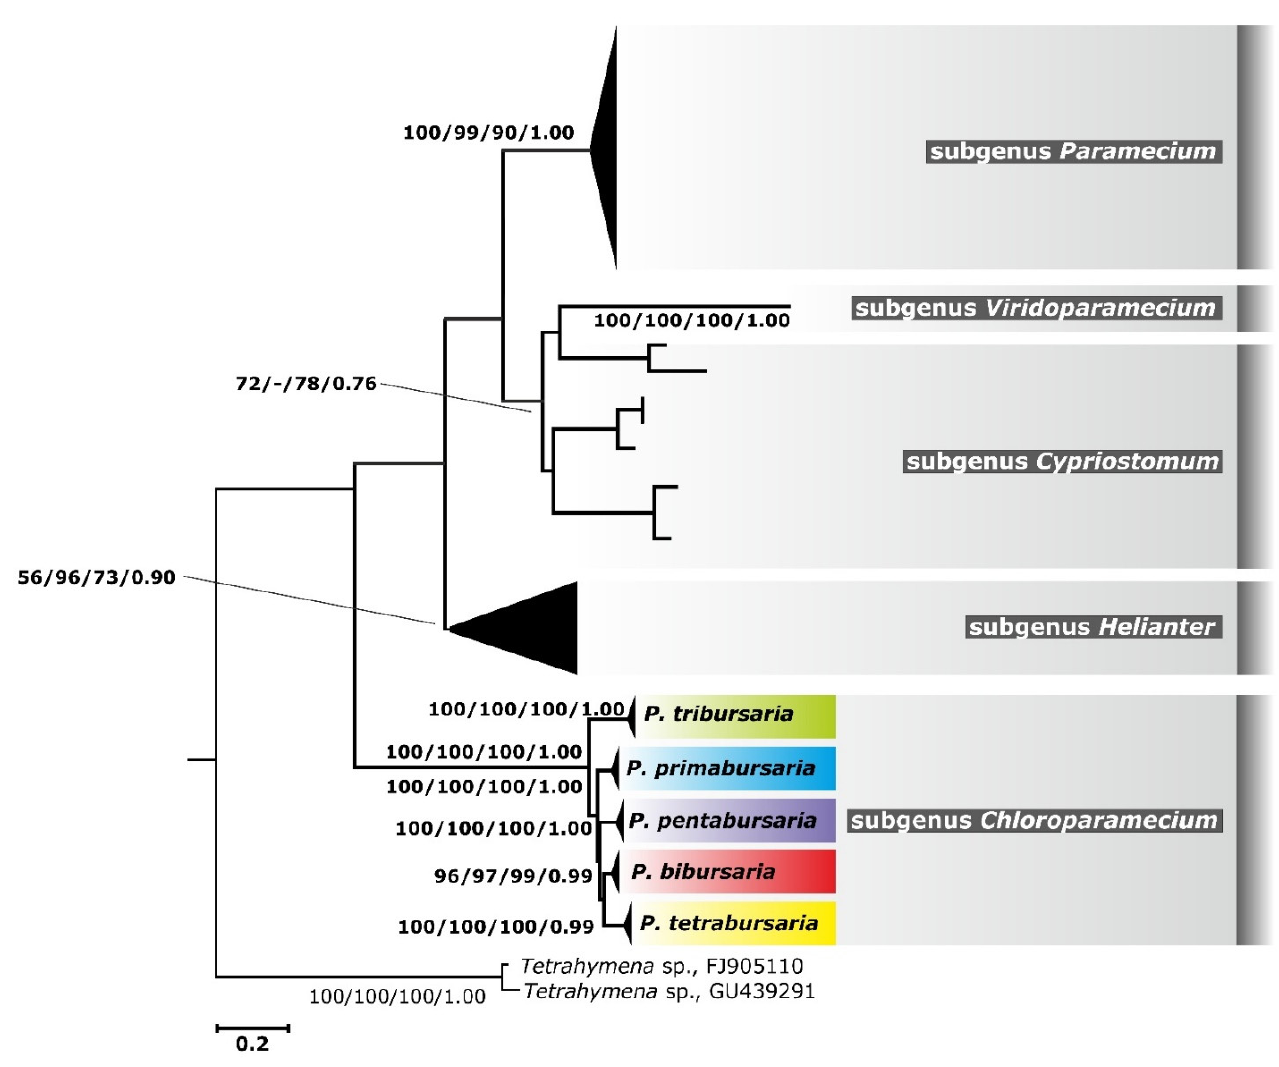
Figure 2. Phylogenetic tree constructed for 132 Paramecium bursaria strains and other Paramecium subgenera (two Tetrahymena species are used as an outgroup). The tree is built on the basis of the mitochondrial COI fragment using the Maximum Likelihood method (ML). Bootstrap values for neighbor joining (NJ), maximum parsimony (MP), maximum likelihood (ML), and posterior probabilities for Bayesian inference (BI) are presented. Bootstrap values lower than 50% (posterior probabilities <0.50) are not shown. Dashes represent no bootstrap or a posterior value at a given node. All positions containing gaps and missing data are eliminated. Phylogenetic analyses are conducted using MEGA v6.0 (NJ/MP/ML) and MrBayes 3.1.2 (BI). The analysis involved 215 nucleotide sequences. There are 649 positions in the final dataset.